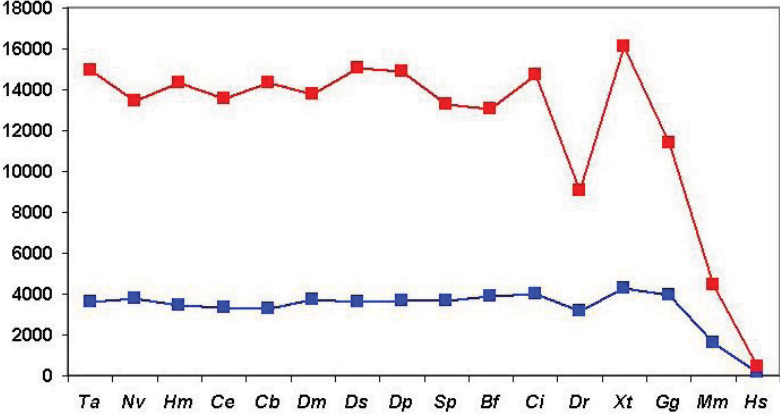
Ta - Trichoplax adhaerens, Nv - Nematostella vectensis, Hm - Hydra magnipapillata, Ce -Caenorhabditis elegans, Cb -Caenorhabditis briggsae, Dm -Drosophila melanogaster, Dp -Drosophila pseudoobscura, Ds - Drosophila simulans, Sp - Strongylocentrotus purpuratus, Bf - Branchiostoma floridae, Ci - Ciona intestinalis, Dr - Danio